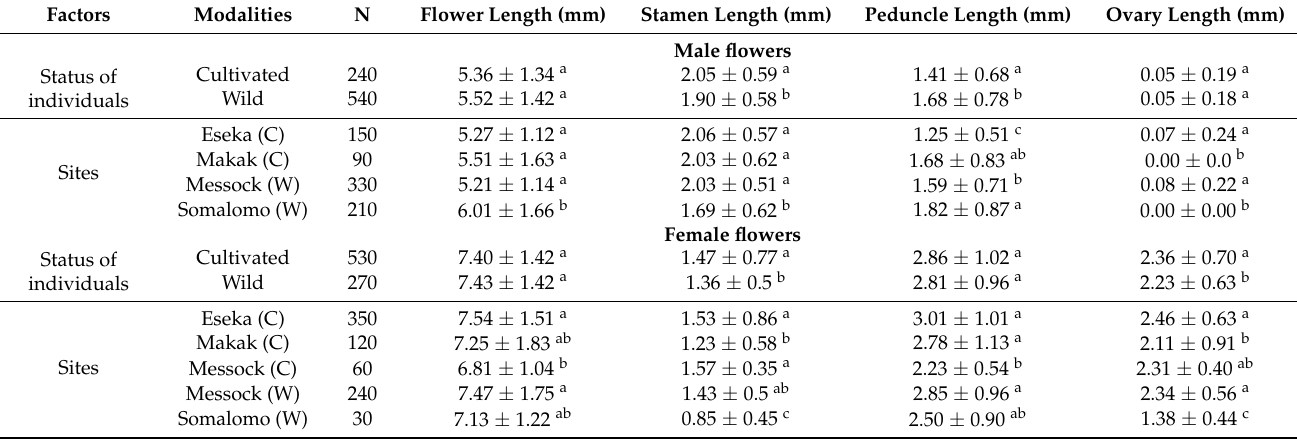
Table 2 . Comparison of flower morphometric parameters in D. edulis according to the sexual type, status of individuals and sites .